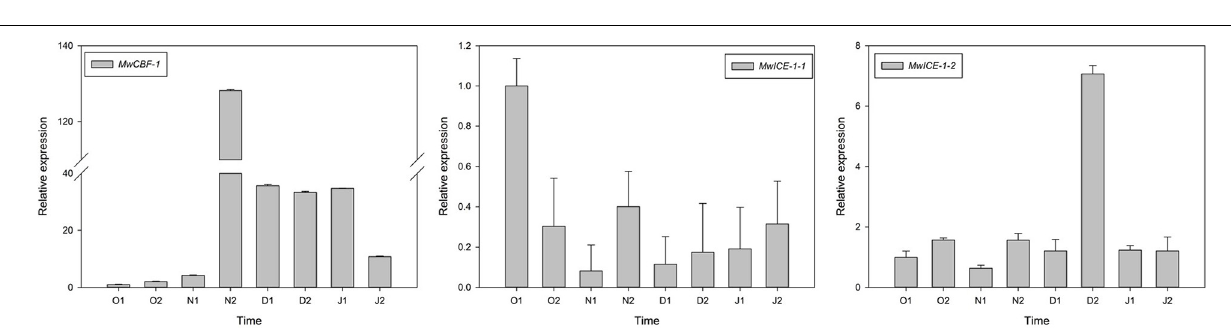
FIGURE 6 | Relative gene expression levels of differentially expressed genes (DEGs) involved in abscisic acid (ABA) biosynthesis (A) , metabolism (B) , and signal transduction (C) under natural condition during 2020–2021 in Magnolia wufengensis . Each experiment was performed with three biological replicates. Each bar represents the mean ± SEM of three biological replicates.